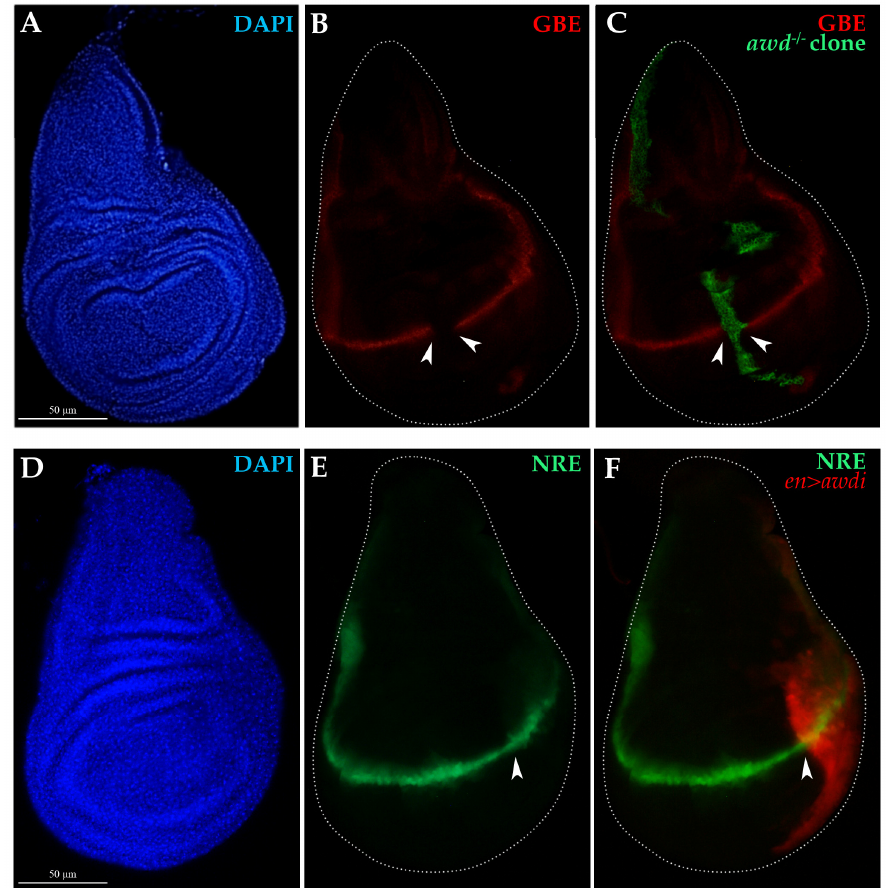
Figure 4. Analysis of Notch signaling in awd − / − clones and en > awdi wing discs. ( A – C ) Fluorescence microscopy image of wing disc dissected from larvae carrying awd J2A4 MARCM clones ( awd − / − ) marked by GFP expression ( C ) and the GBE-lacZ transcriptional reporter for Notch activity. Wing discs are labelled by DAPI ( A ), anti- β -Gal ( B , C ) and GFP ( C ). ( D – F ) Fluorescence microscopy image of wing disc dissected from en > awdi larvae carrying the NRE-eGFP ( E , F ) transcriptional reporter for Notch activity. Wing discs are labelled by DAPI ( D ) and RFP marking the posterior domain ( F ). White dots outline wing discs, white arrowheads mark respectively the boundary of the MARCM clone ( B , C ) or the boundary of the posterior compartment ( E , F ).